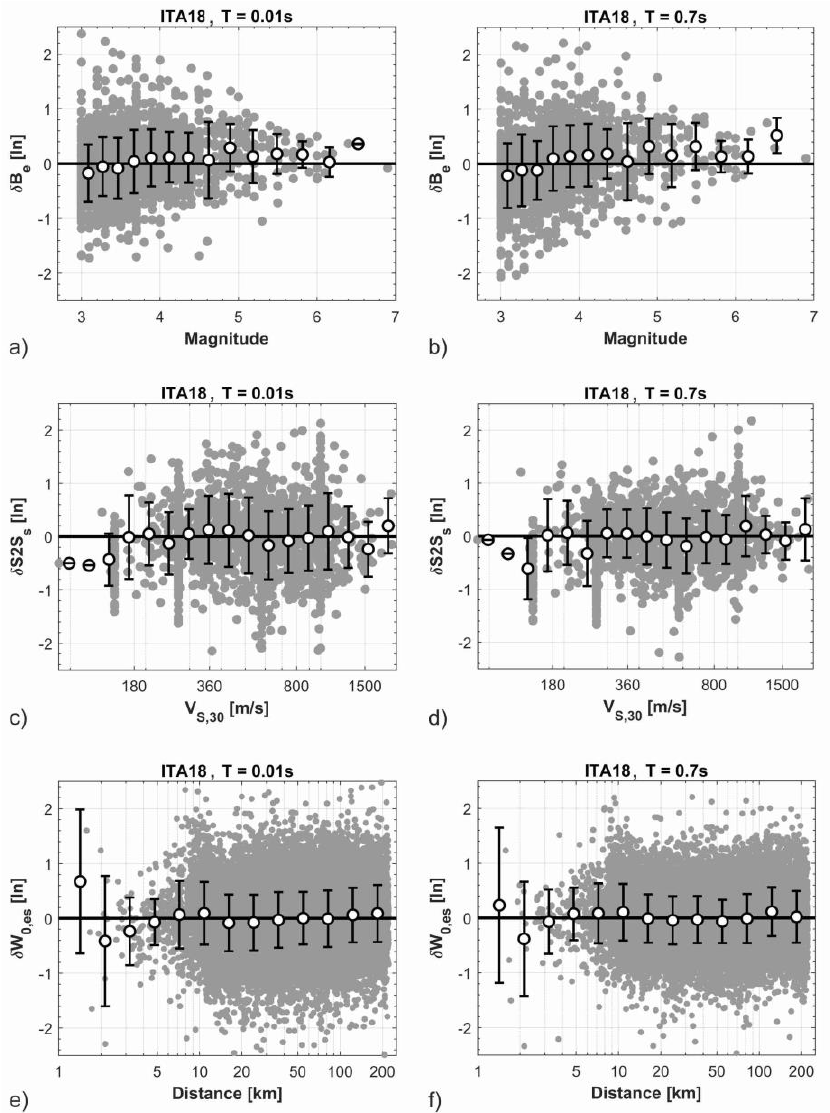
Figure 2. offset term a 0 , normalized for the total standard deviation of the ITACAext residuals.